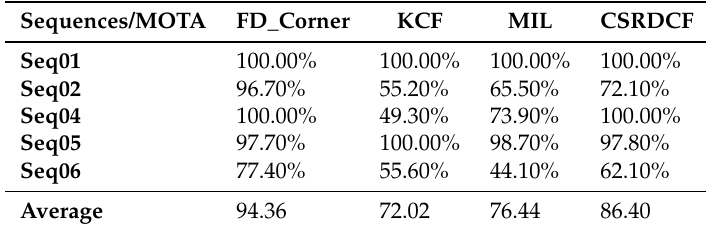
Table 6. Comparison of the baseline and stare of art trackers with FD corner in terms of robustness to initialisation. Our tracker FD_Corner was the most robust tracker to